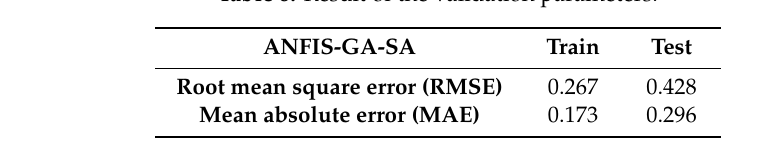
Table 7. Result of the area under the curve (AUC) for the two models.